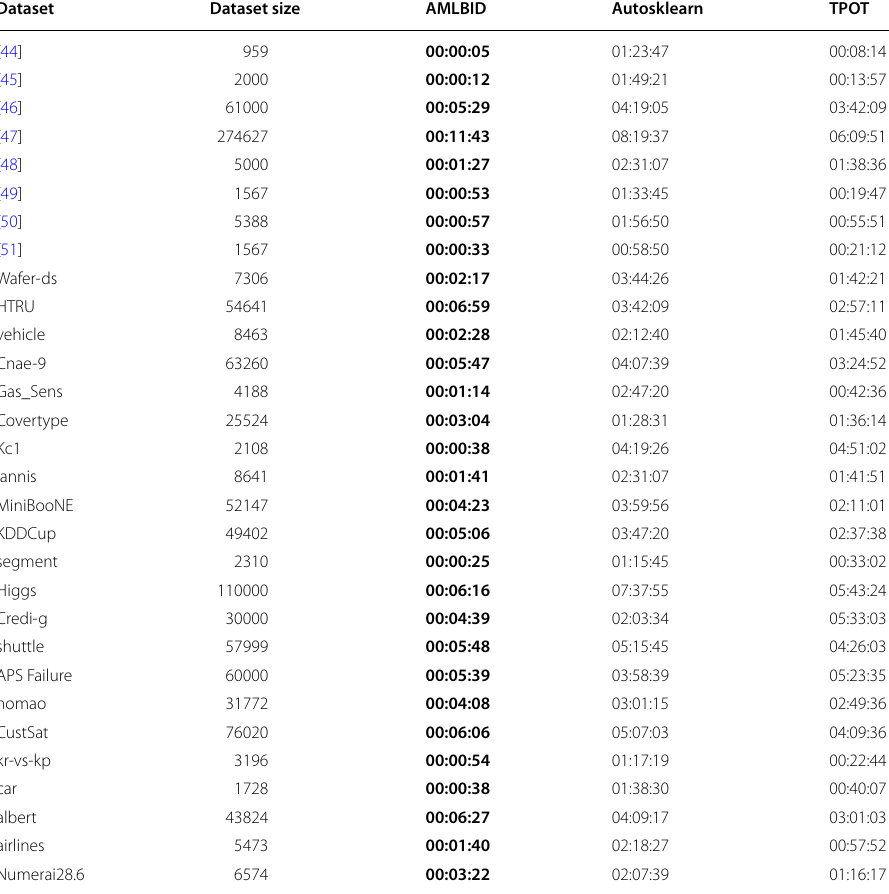
Table 8 The run-time (in HH:MM:SS format) of the AMLBID, Autosklearn and TPOT tools on the benchmark